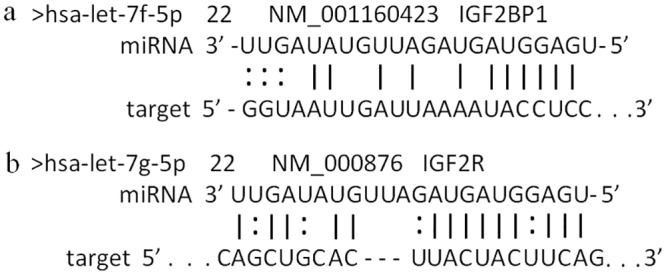
(a) Let-7f-5p was predicted to bind to a site on the IGF2BP-1 mRNA. (b) Let-7g-5p was predicted to bind to a site on the IGF-2R mRNA.